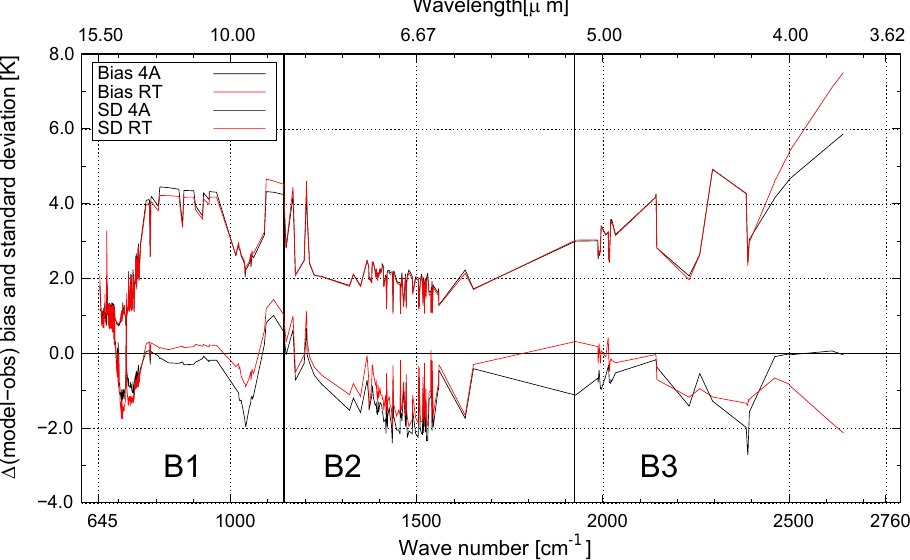
Figure 5. Bias (straight lines) and SD (dashed lines) of differences between model simulations and observations in 314 channels for the 789573 IASI observations taken under clear-sky conditions according to the AVHRR cloud flag during daytime and night-time and above all surface types. B1, B2 and B3 correspond to the three IASI